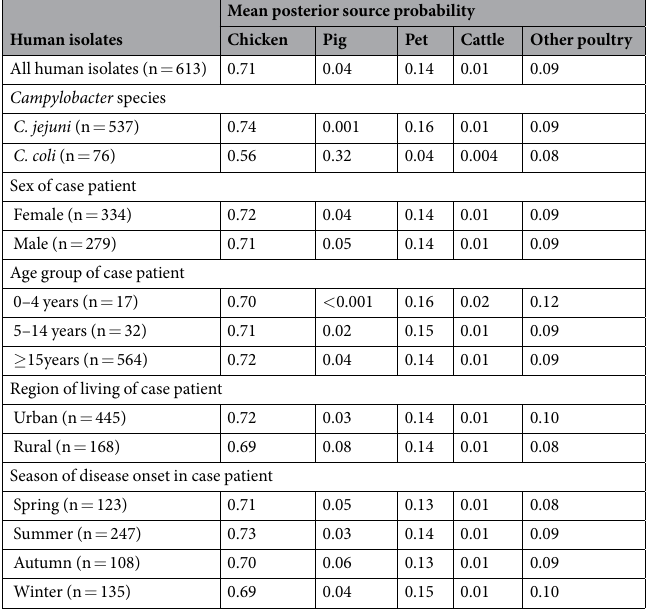
Table 6. Mean posterior probabilities of human isolates of originating from one of the putative sources (chickens, pigs, pet dogs or cats, cattle, poultry other than chicken (duck, goose, turkey, quail: “other poultry”)) as determined by asymmetric island source attribution modelling based on MLST data. Stratification according to Campylobacter species or characteristics of the case patients. Due to rounding of numbers the sum of probabilities may not add up to